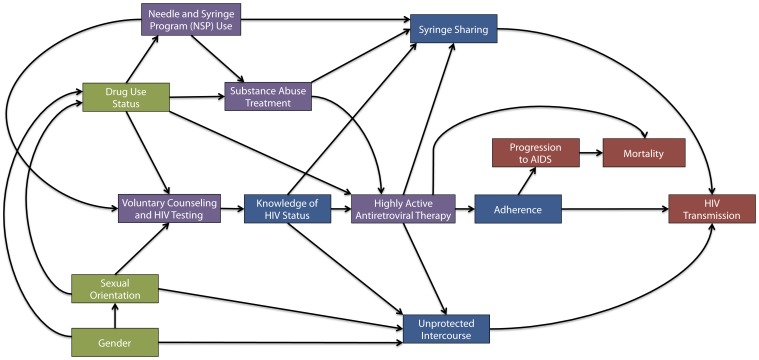
Conceptual framework of the HIV transmission agent-based model.Arrow represents causal effects between two phenomena in the model. For example, NSP use increases an agent’s probability of HIV testing, which is turn can result in both the knowledge of an HIV positive status and initiation of antiretroviral therapy. Green boxes represent agent characteristics that influence individual agent behavior, denoted in blue. Purple boxes represent interventions that influence these behaviors. Red boxes represent model output.